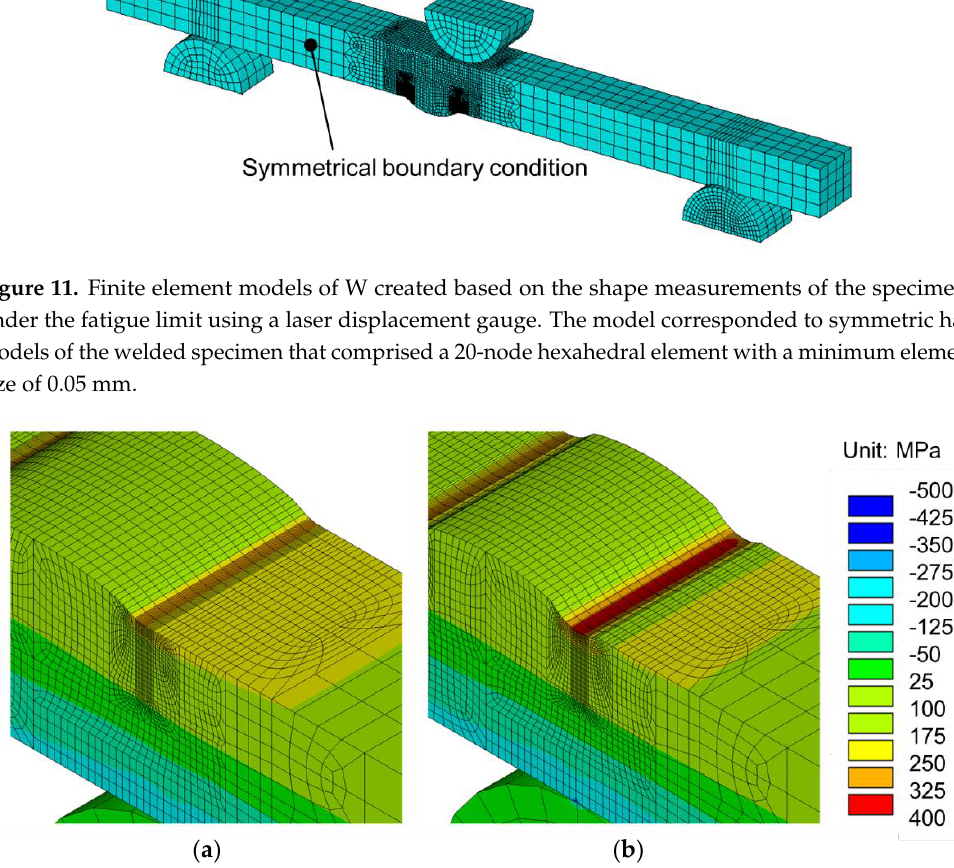
Figure 12. Contour of the longitudinal stress at a normal bending stress of 200 MPa for: ( a ) W and ( b ) WN.